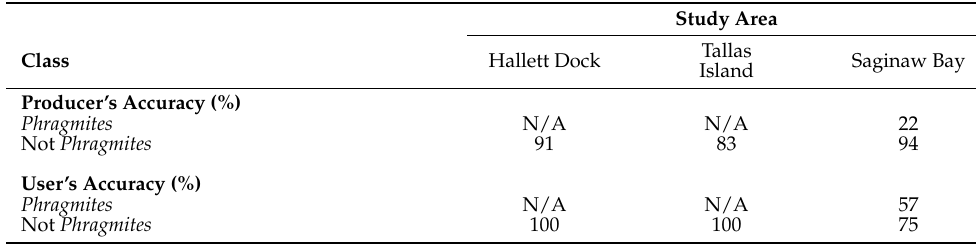
Table 10. Classification performance for all four study sites when using the RGB UAS imagery with a stereo satellite-derived CHM. Only the accuracy of the Not Phragmites class was calculated for Hallett Dock and Tallas